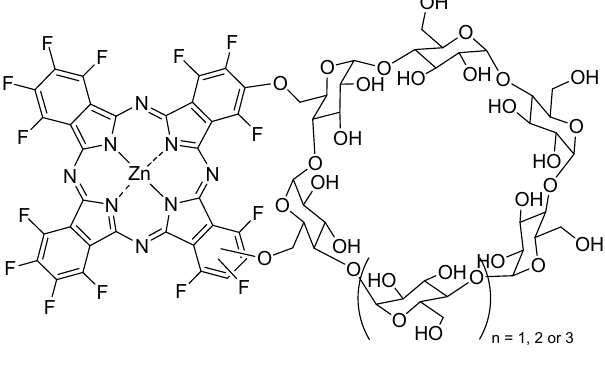
Figure 31. Chemical structure of ZnPc- α -CD, ZnPc- β -CD, and ZnPc- γ -CD conjugates.